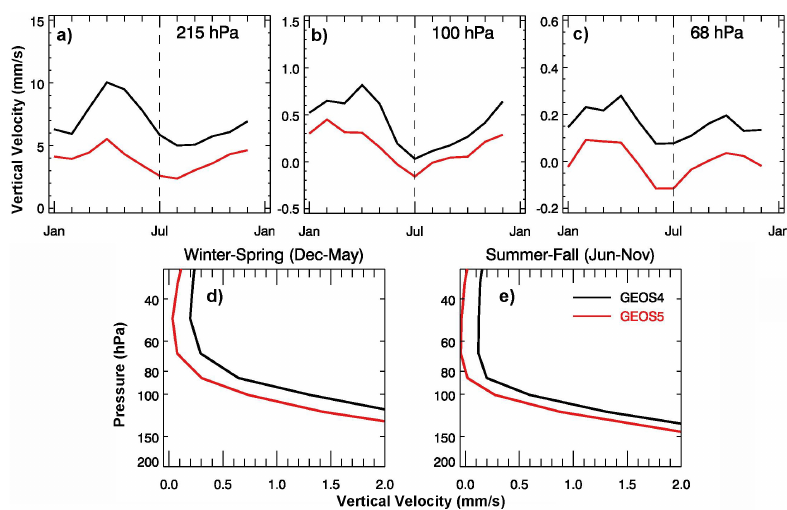
Fig. 10. Monthly variation of the tropical (10 ◦ S–10 ◦ N) vertical velocity at (a) 215hPa, (b) 100hPa, and (c) 68hPa. The lower panels show the profile of the seasonal mean vertical velocity during (d) boreal winter-spring (December to May) and (e) boreal summer-fall (June to November). Red lines show model results from GEOS-5 and black lines show those from GEOS-4.